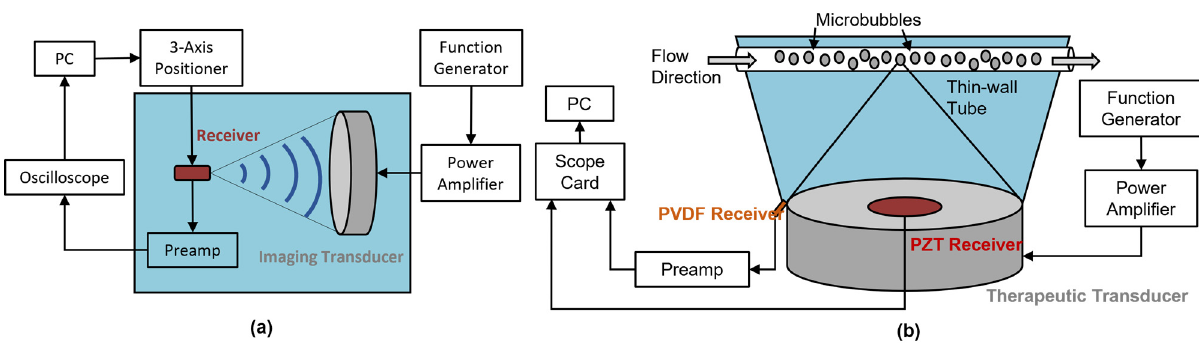
Figure 2. Sensitivity calibration setup ( a ) and bubble monitoring setup ( b ). In the calibration setup ( a ), a 3-axis positioner was controlled by a personal computer (PC) to adjust the receiver position until the location of maximum output signal was found, as shown on the oscilloscope. An imaging transducer was used to transmit sine waves sent out from the function generator and power amplifier, creating an acoustic field in the deionized and degassed water tank. In the benchtop bubble monitoring setup ( b ), the newly developed PVDF receiver with the in-house PZT receiver used for in vivo studies was compared by simultaneously capturing the acoustic emission from MBs. Preamp is a short form of preamplifier in both schematics.